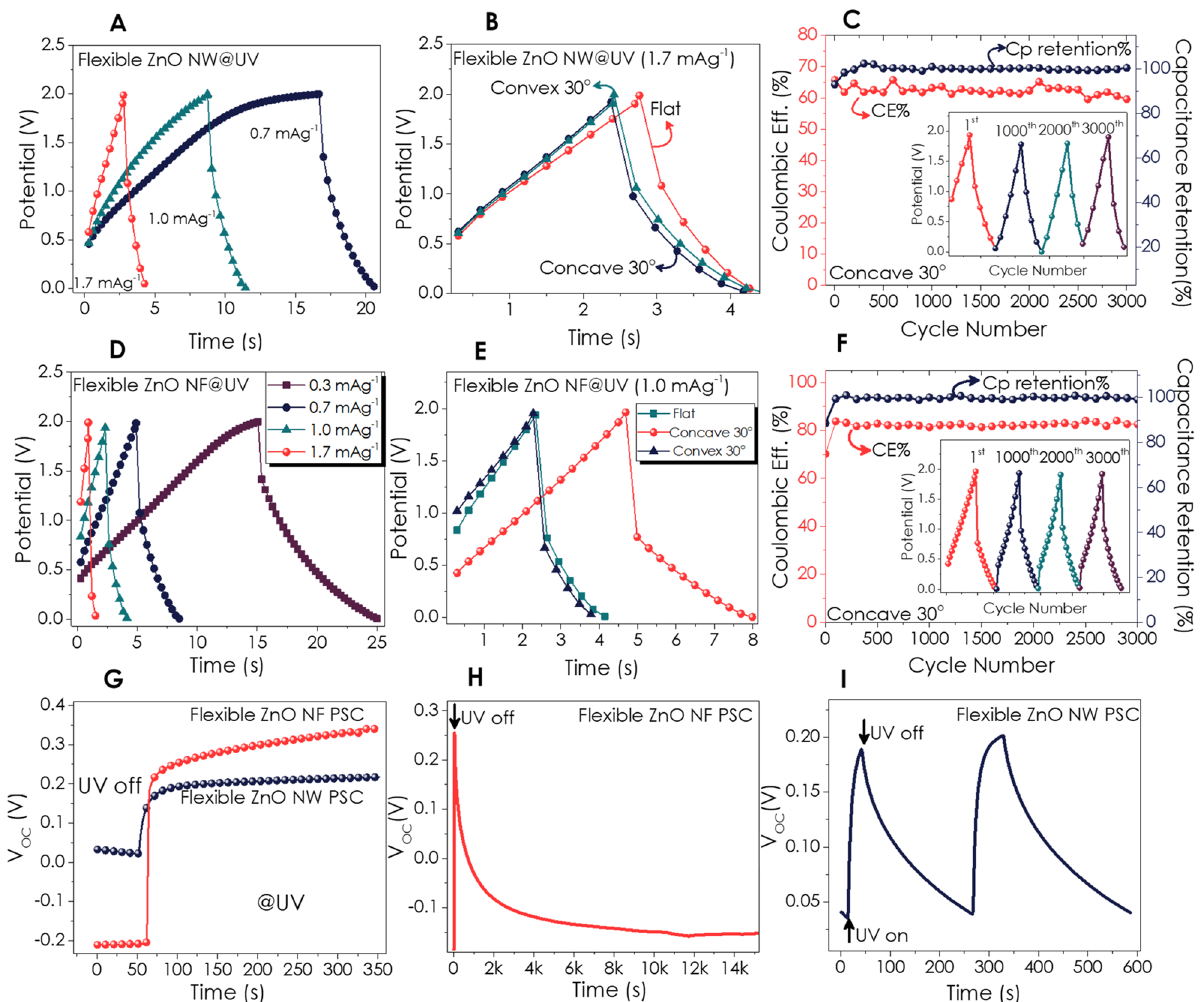
Figure 7. GCD curves for Flexible ZnO NW P-SCs; ( A ) at various current densities under UV light, ( B ) comparison of the GCD curves of flat and bent P-SC, ( C ) CE% and capacitance retention of concave P-SC, GCD curves for Flexible ZnO NF; ( D ) at various current densities under UV light, ( E ) comparison GCD curves of flat and bent P-SC, ( F ) CE% and capacitance retention of concave P-SC; Open circuit potential (V OC ) curves; ( G ) at dark and under UV illumination for 5 min, V OC response to chopped light and relaxation duration for flexible ( H ) ZnO NF and ( I ) NW P-SC